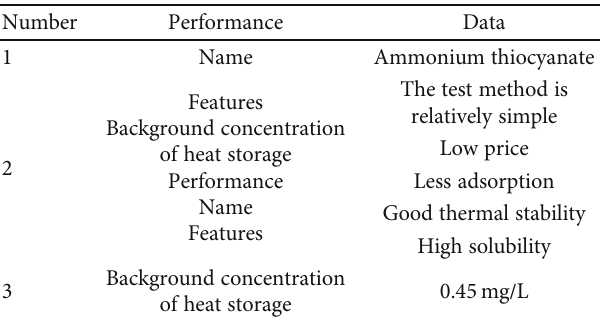
Table 5: Characteristics of selected tracer.